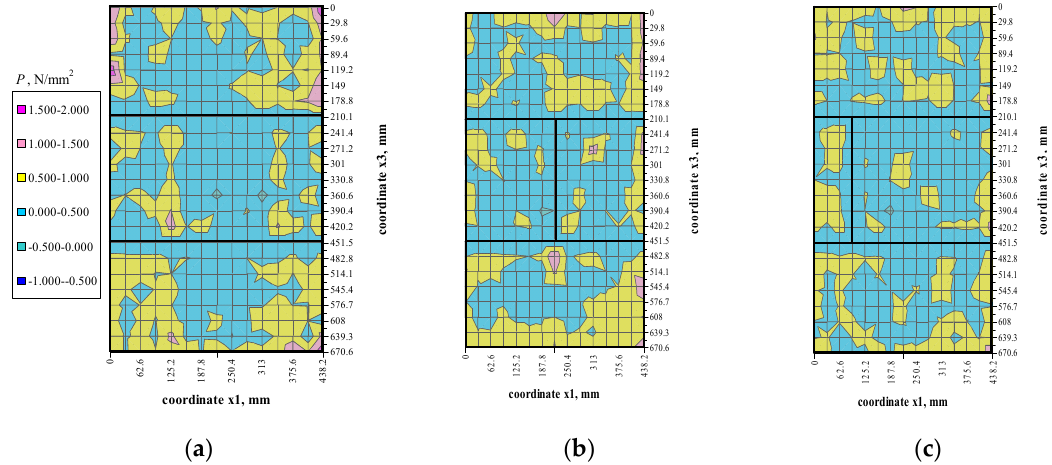
Figure 15. Mean hydrostatic stress values P at load σ 3 = 0.50 σ 3max : ( a ) model I-1, ( b ) model II-1, ( c ) model III-1.